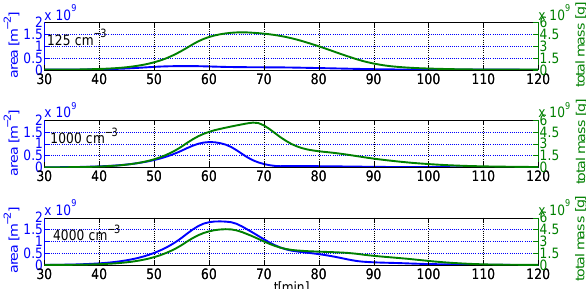
Figure 4. The total cloud water mass (green) and the total droplet surface area (blue) as a function of time for three clouds with aerosol levels of 125 (upper panel), 1000 (middle panel), and 4000 cm − 3 (lower panel) for profile